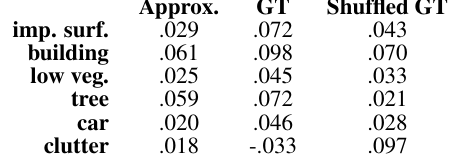
Figure 10. Domain adaptation example. Source domain: Buxtehude. Target domain: Nienburg. From left to right: input image patch, ground truth, using Random strategy, using Ground Truth strategy, using our Approximation strategy. Despite domain adaptation, there are still large regions which are misclassified. Our approach mitigates this issue partially, e.g., w.r.t. the class clutter (yellow). Approx.